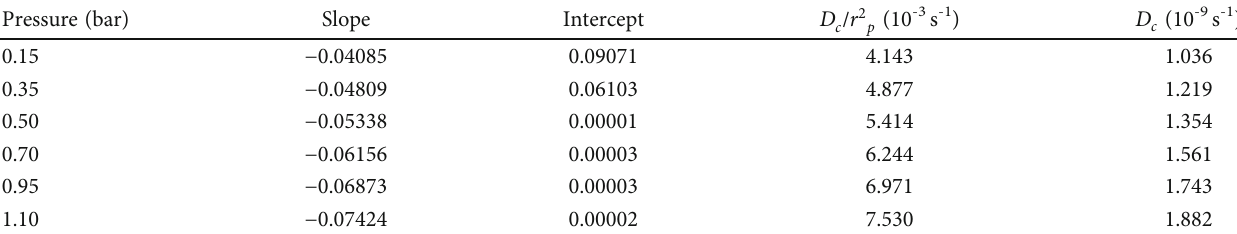
Figure 13: Linear fi tting for experimental data with interparticle di ff usion model. Table 4: The linear fi tting results for interparticle di ff usion